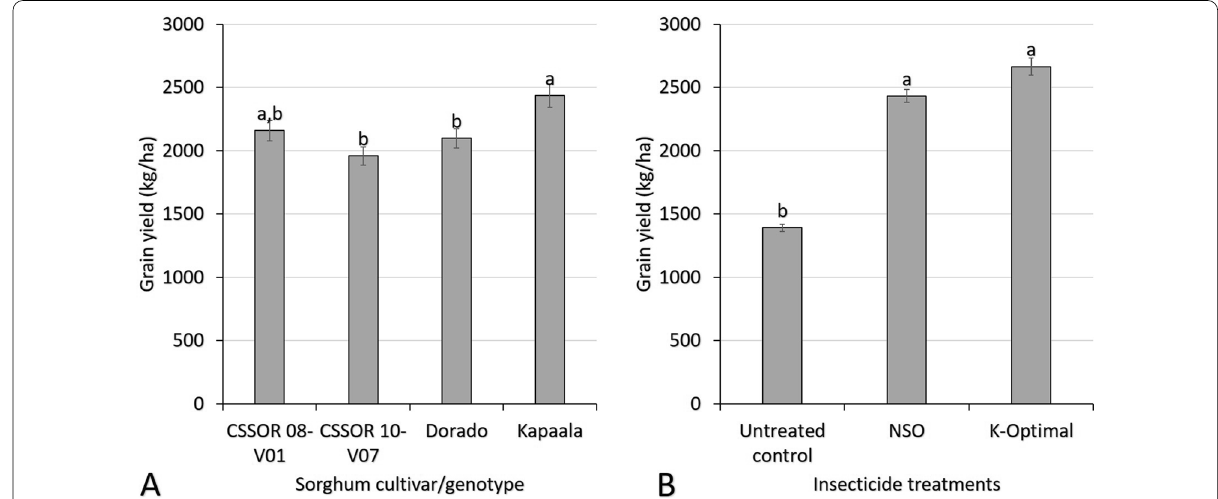
Fig. 6 Effect of insecticide treatments ( A ) and cultivars/genotypes ( B ) on grain yield (kg/ha) of sorghum in 2018 cropping season. Data are means standard error of means (S.E.M.). NSO Neem seed oil; Bars with different letters are significantly different at 5% probability ± =